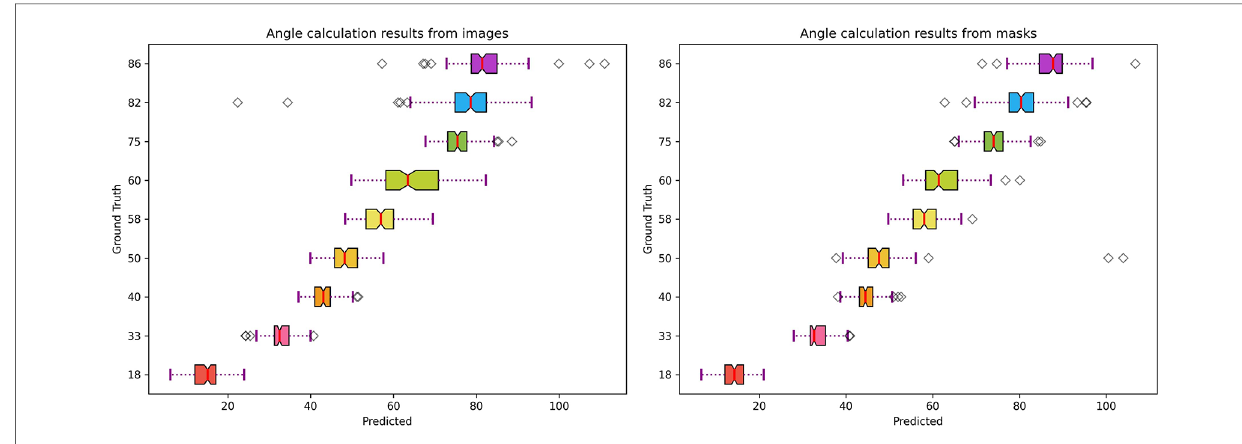
FIGURE 8 Curvature angle estimation performance from penile model images and derivative masks.